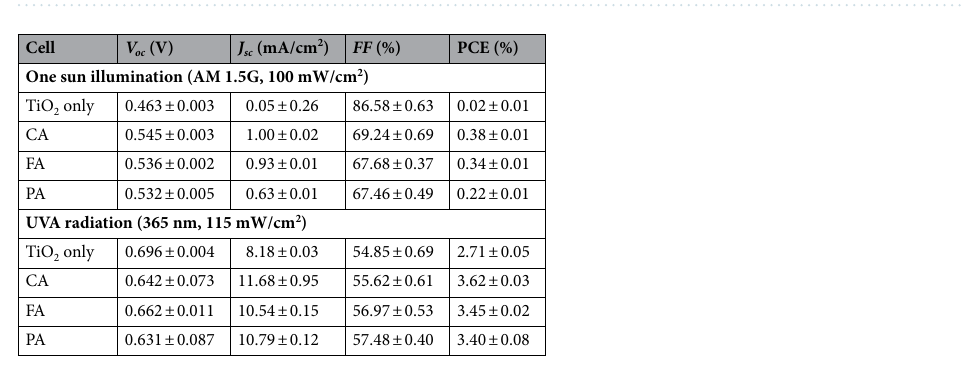
Table 2. Photovoltaic performance of DSSCs sensitized with CA, FA, and PA under one-sun illumination (AM 1.5G, 100 mW/cm 2 ) and UVA radiation (365 nm, 115 mW/cm 2 ).